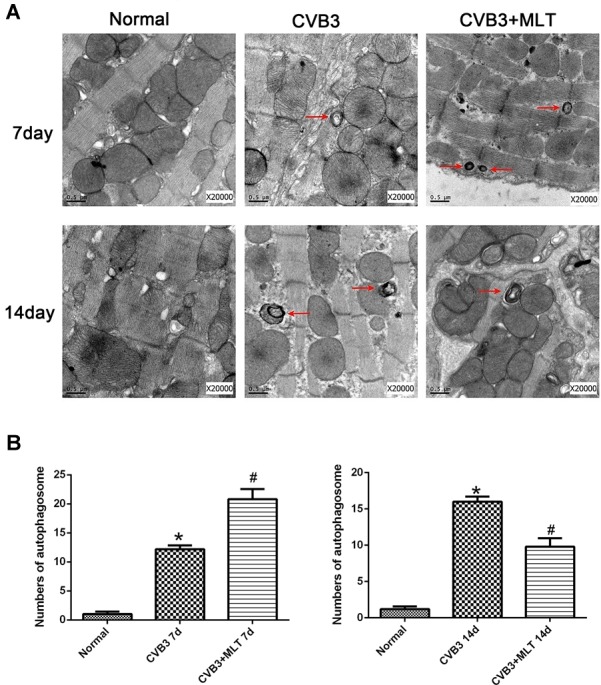
Transmission electron microscopy showing the myocardial microstructure and autophagosomes (red arrowheads) on days 7 and 14 (scale bars = 0.5 μm). (A) Representative transmission electron microscopy image. (B) The results of the statistical analysis of the numbers of autophagosomes from 20 fields (n = 5 hearts per group). ∗P < 0.05 versus the normal group, #P < 0.05 versus the CVB3 group.